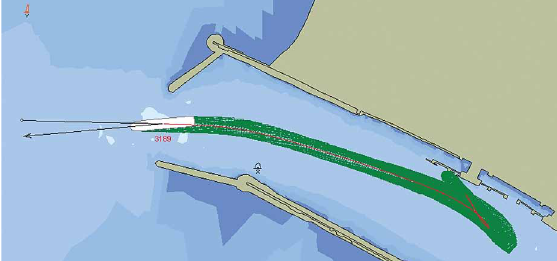
Fig. 11. The trajectory of PANAMAX tanker unberthing and leaving the